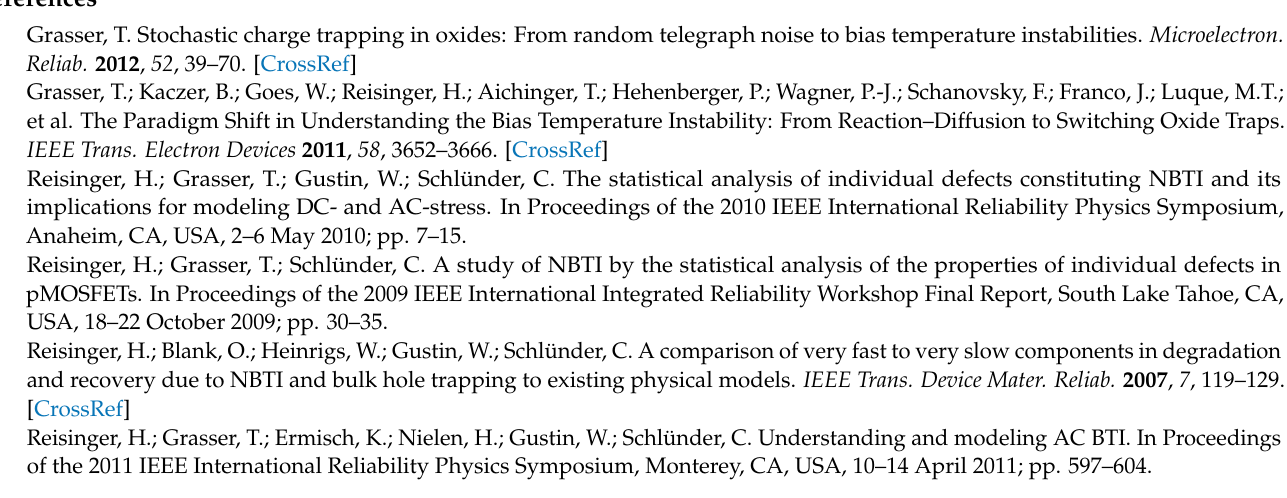
Figure 4. 1/ f noise spectrum and threshold voltage shifts for 𝑡 (cid:3046) = 1000 s . ( a ) 𝑆 (cid:3023) (𝜔) versus ∆𝑉 (cid:3047)(cid:3035) for 𝑁 (cid:3047)∗ = 2.0 (cid:3400) 10 (cid:2869)(cid:2870) cm (cid:2879)(cid:2870) . ( b ) S V th for N (cid:3282) t g